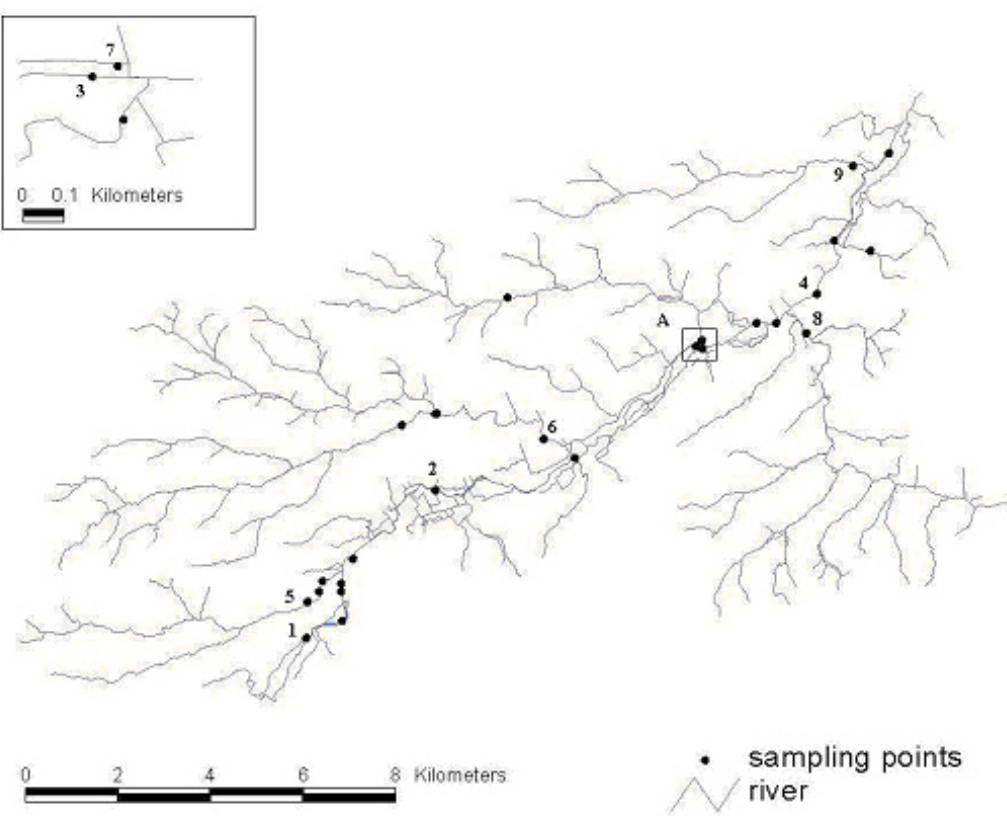
FIGURE 3. Sampling sites of the Flemish Environmental Agency (VMM) in the Dender